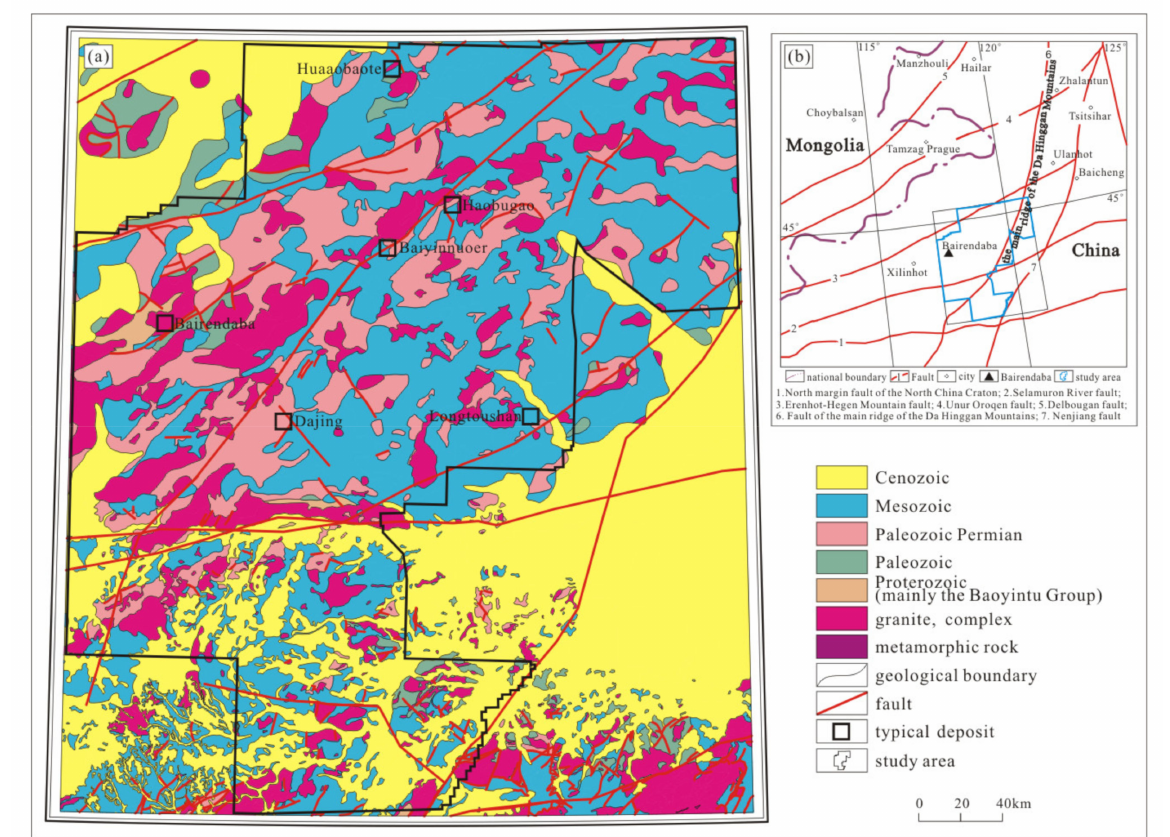
Figure 1. The geological ( a ) and geotectonic ( b ) map of the study area [32–37]. The rocks exposed in the region belong to the Paleoproterozoic Baoyintu Group